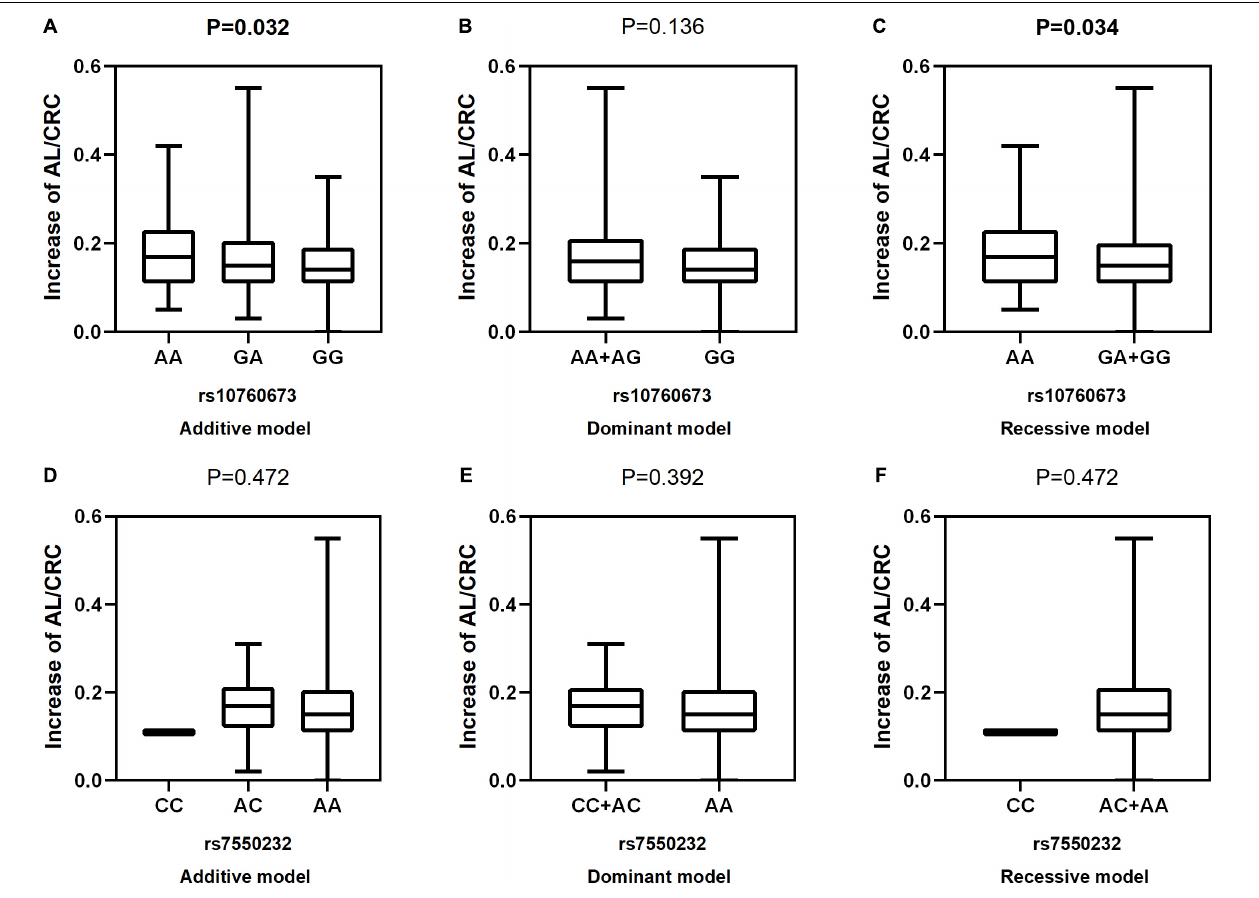
FIGURE 5 | Correlations between the two SNPs and an increase in AL/CRC. rs10760673 [ (A) additive model, p = 0.032; (B) dominant model, p = 0.136; (C) recessive model, p = 0.034]; rs7550232 [ (D) additive model, p = 0.472; (E) dominant model, p = 0.392; (F) recessive model, p =